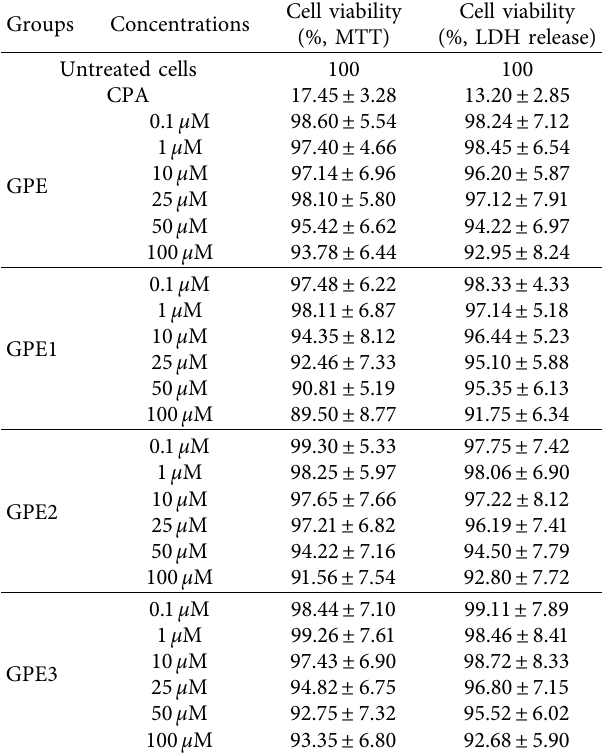
bilities in cultured human pluripotent embryonal carcinoma NT2 cells. ∗ symbol presents a statistical diference from the control (-) group at the level of p < 0 .